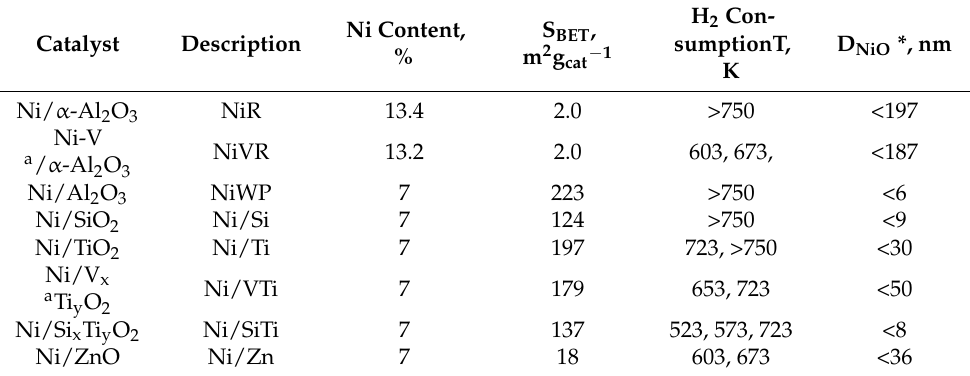
Table 2. Selected properties of synthesized